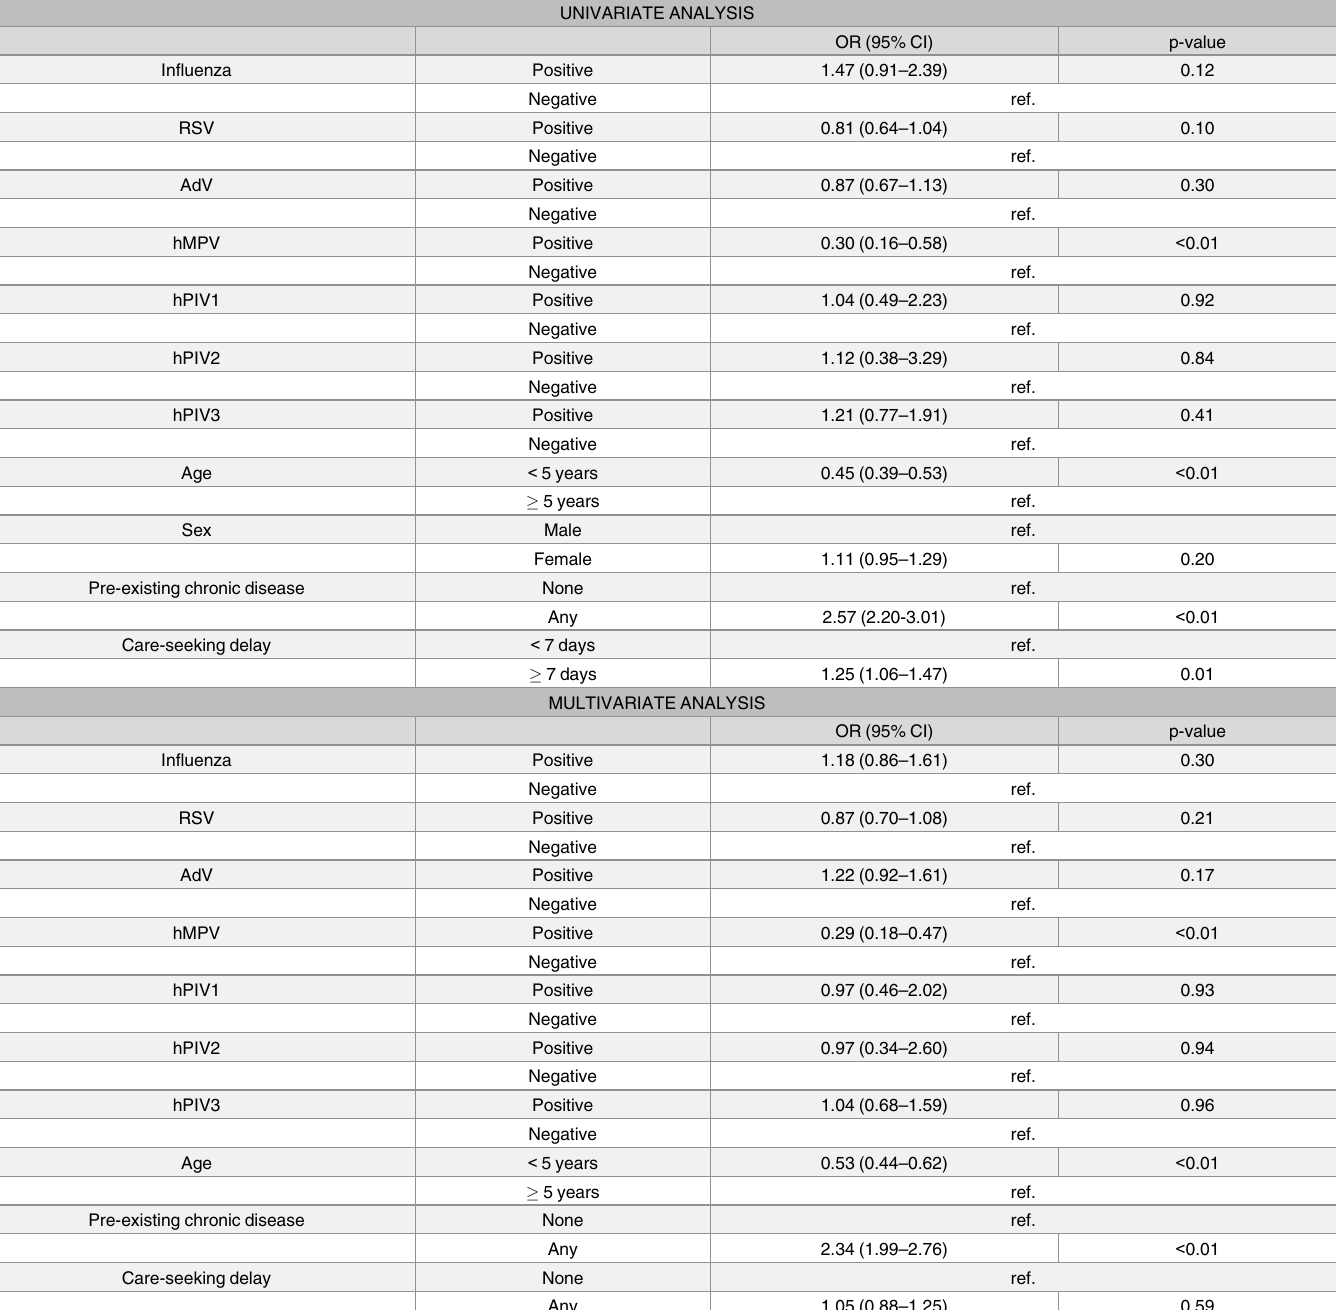
Table 4. Univariate and multivariate logistic regression examining predictors of severeoutcomes. Includesonly individualsfor whom testing for the full panel of viral respiratory viruses was performed and for whom data on demographicsand clinical risk factors are complete. Severe outcome is definedas illnessrequiringventilation or intensivecare or resultingin